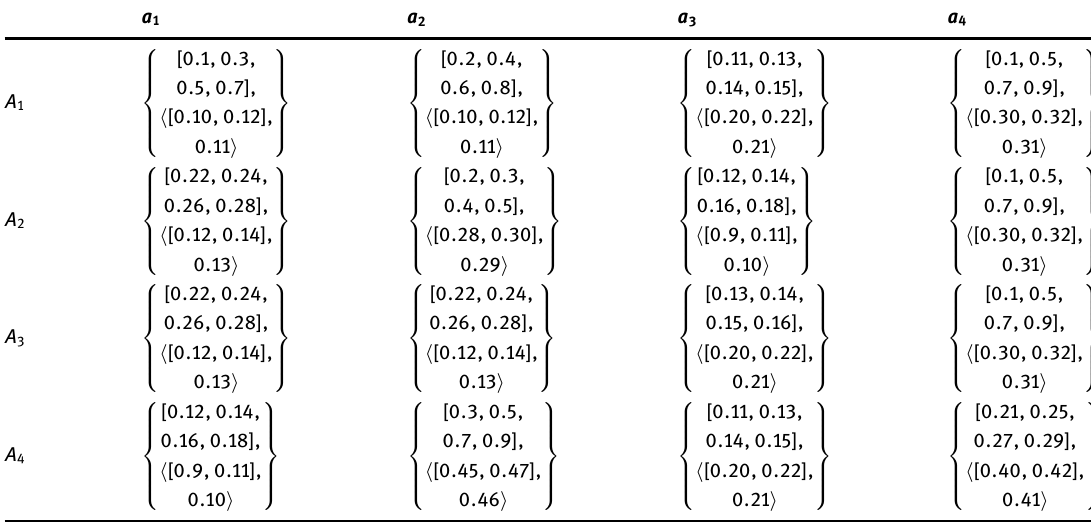
Table 3: Decision Matrix Given by Expert p 3 .